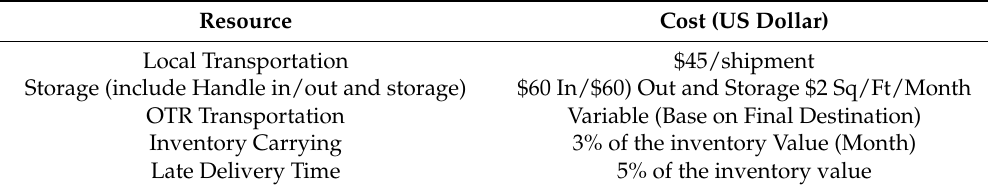
Table 1. Resources Considered in the Logistics